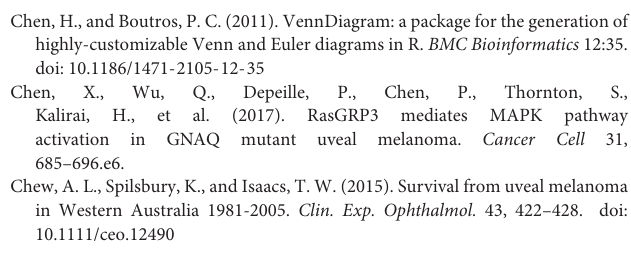
Supplementary Figure 1 | GO and KEGG analyses of all DEGs. (A) GO functional enrichment analysis of all DEGs. (B) KEGG pathways analysis of all DEGs. Supplementary Figure 2 | Correlation analysis diagram between autophagy-related genes and